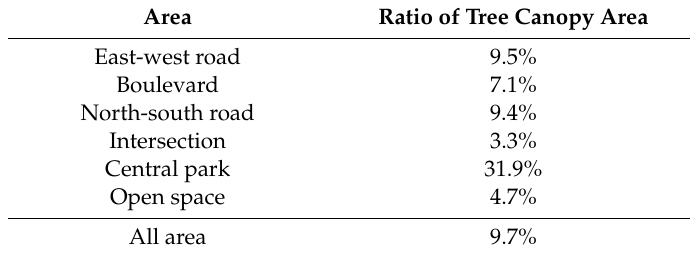
Figure 7. Distribution of trees in the study area. Table 1. Ratio of tree canopy area in each study area.